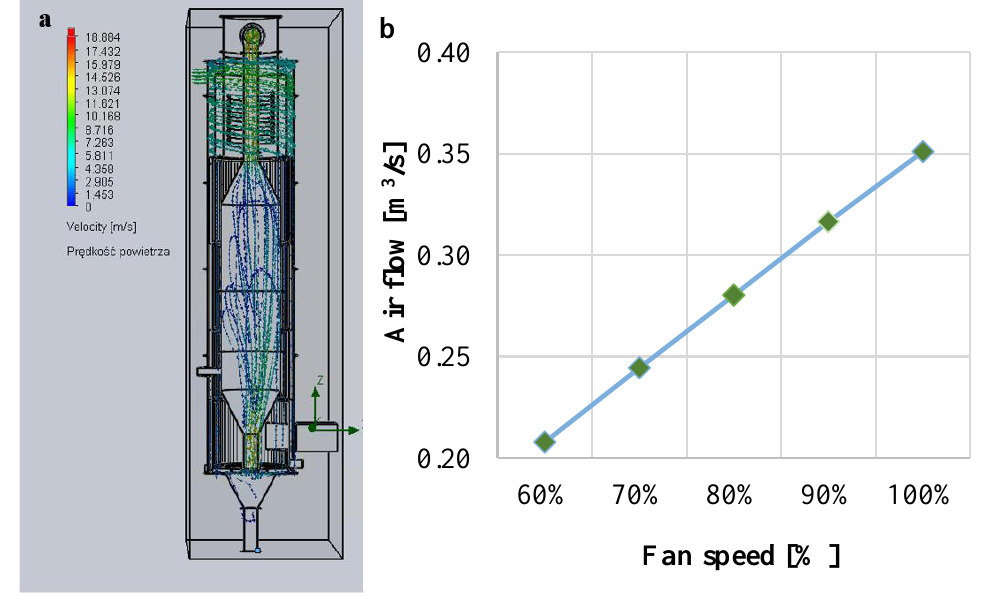
Figure 7. ( a ) Air velocity distribution inside the dryer. ( b ) Characteristics at the fan speed to the amount of airflow inside the dryer.